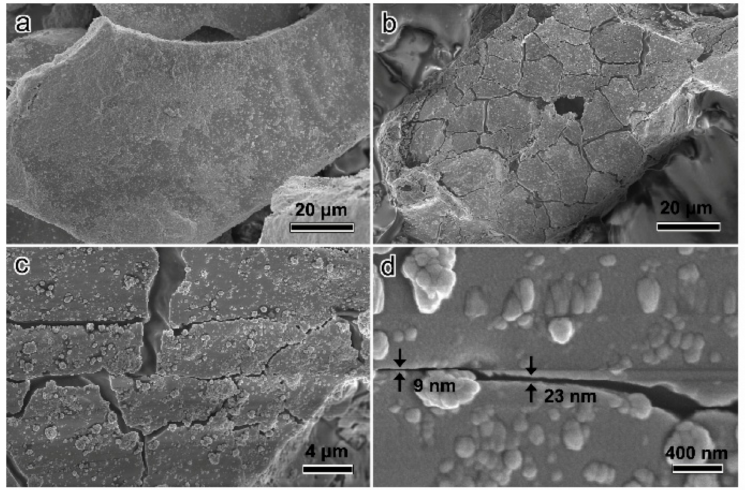
Figure 4. ( a ) SEM characterization of the Au/SAP structures before dropping deionized water. ( b – d ) SEM characterization of the Au Gaps obtained by the water-swelling-driven